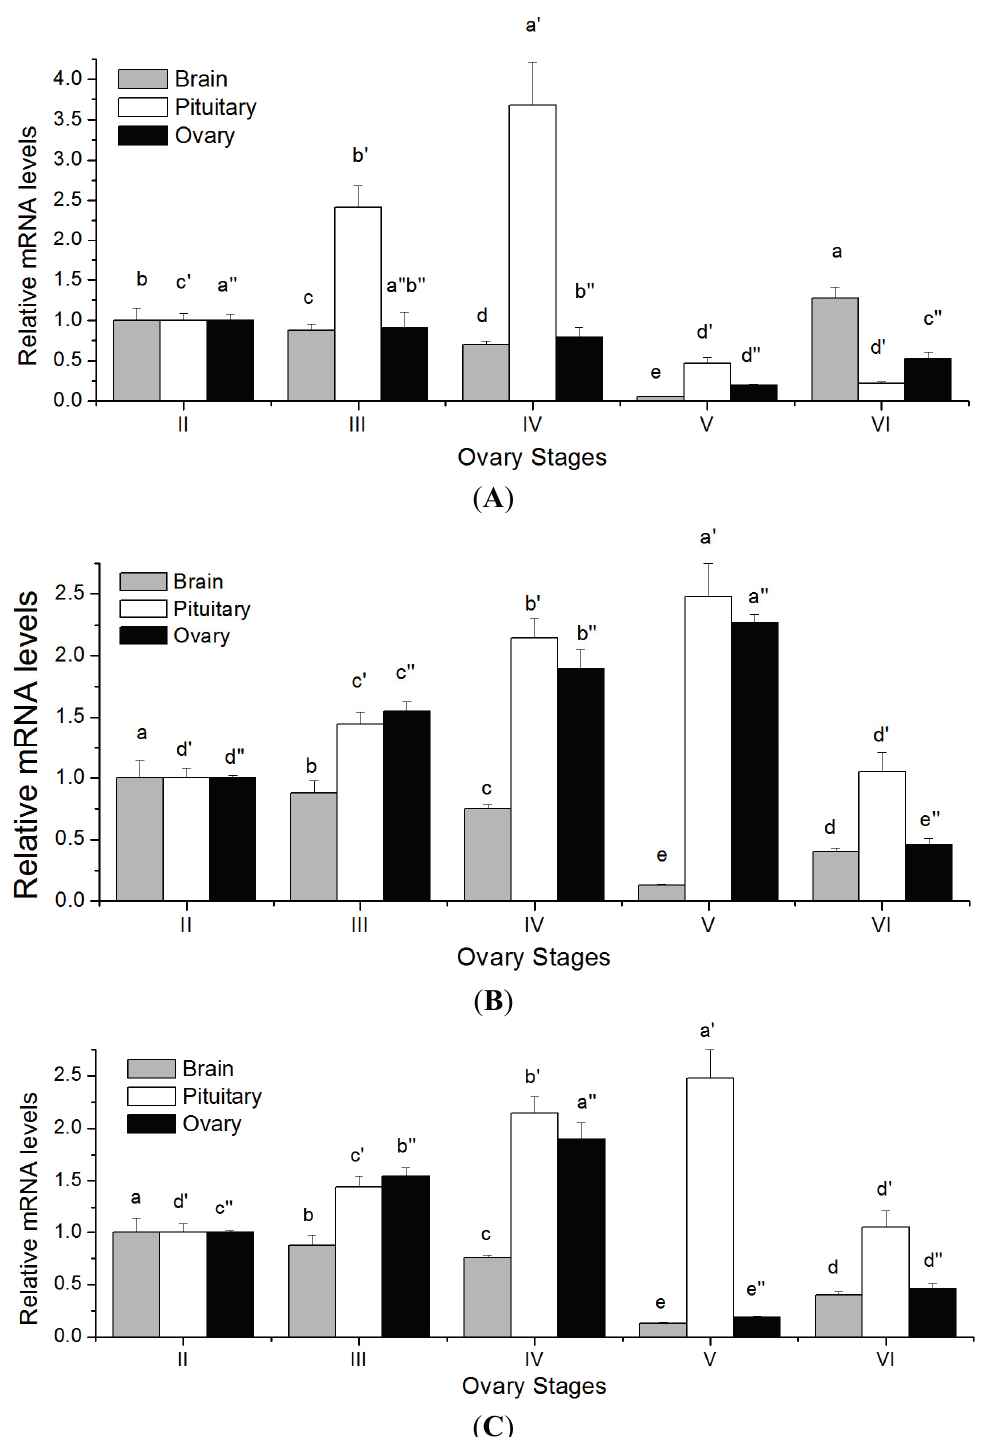
Figure 7. Relative mRNA expression levels of FSH β , LH β and CG α mRNA at different ovary stages in maturing C. semilaevis . Abundance of FSH β ( A ), LH β ( B ) and CG α ( C ) transcripts, respectively, was determined by quantitative real-time PCR and normalized to 18S ( n = 4). Each bar represents the mean ± SE. Tissues marked by the different letters differ significantly from each other ( p < 0.05). The superscript “'” denotes the letter of statistical significance difference in the pituitary at different ovary stages. And the superscript “''” denotes the letter of statistical significance difference in the ovary at